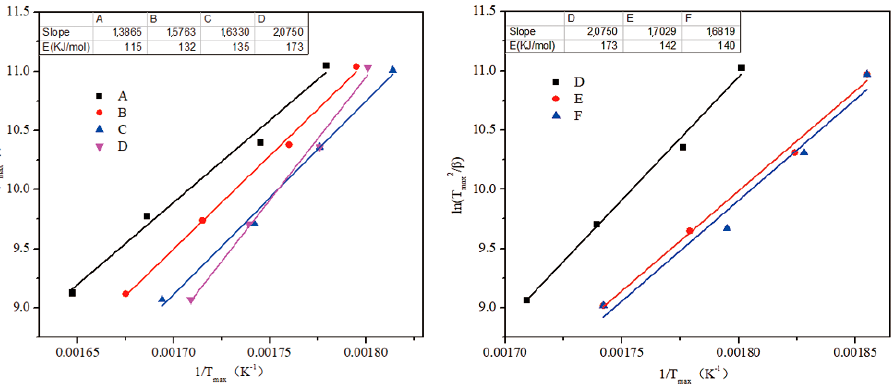
Figure 12. Decomposition activation energy of HPN-EPPA-UR-PA resin with different phosphorus and nitrogen content.